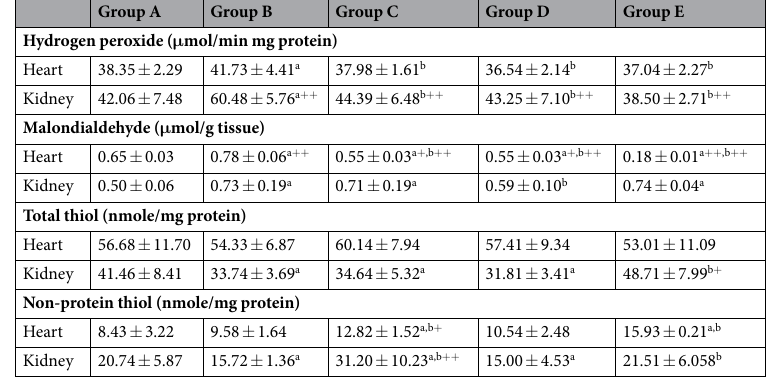
Table 2. Effect of pretreatment of CurNisNp on markers of oxidative stress in MI induced guinea pigs. Note; results in the table above are in Mean ± standard deviation of each group of five guinea pigs. a P < 0.05 compared with group A; a + P < 0.01 compared with group A; a ++ P < 0.001 compared with group A; b P < 0.05 compared with group B; b + P < 0.01 compared with group B; b ++ P < 0.001 compared with group B.